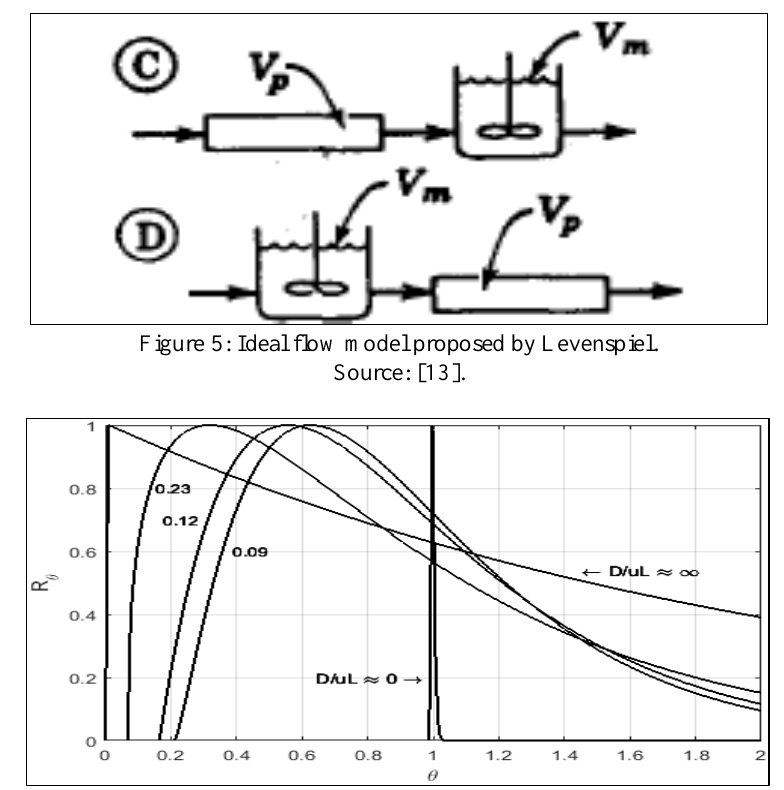
Figure 6: Simulations performed in MATLAB® of the Rϴ vs ϴ Curve for open systems with different back mix intensities (D/uL) predicted by the proposed model. Source: